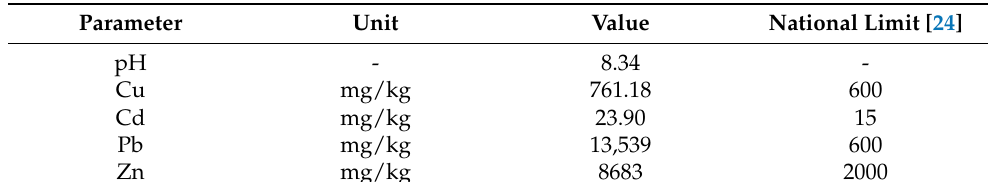
Figure 4. Soil pH under different treatment conditions (control, BFS, and CS).